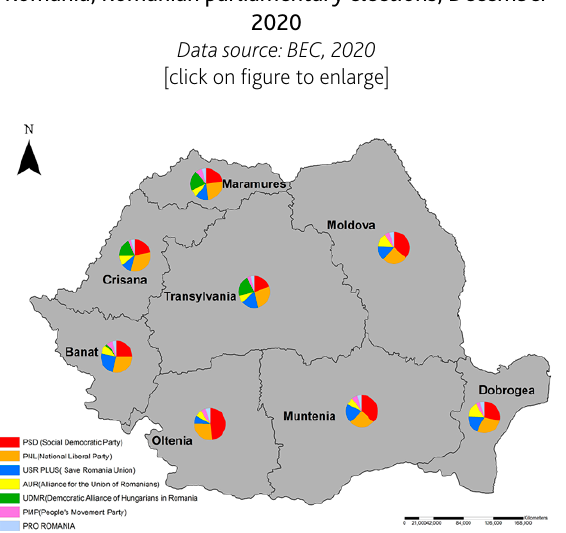
Figure 3. Vote share for the main parties in the historical regions of Romania, Romanian parliamentary elections,